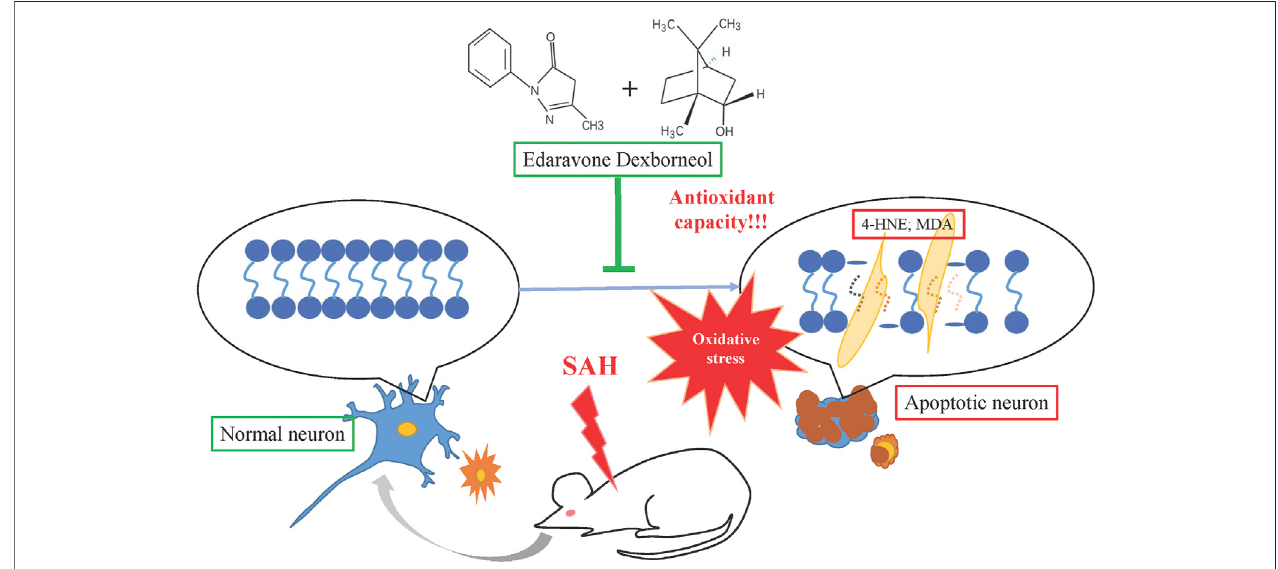
FIGURE 9 | Schematic illustration of the mechanisms by which edaravone dexborneol afforded neuroprotection against SAH-induced brain injury. SAH could causeneuronal apoptosisbyinducingoxidative stressinjury.Edaravonedexborneol treatmentattenuatesneuronalapoptosisbyaffordingpowerfulantioxidant capacity after SAH, accompanied by the inhibition of lipid peroxidation products such as 4-HNE and